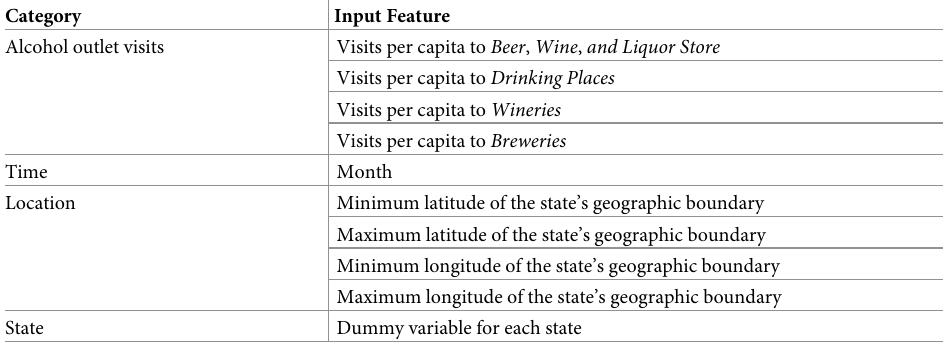
Table 1. Four categories of input features for the machine learning